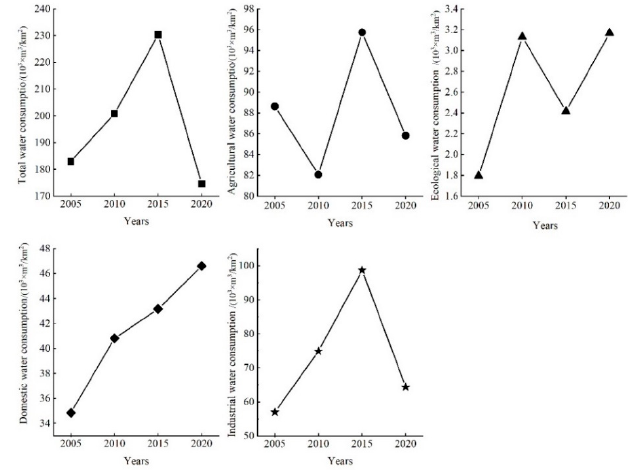
Figure 6. Water demand by type per unit area.